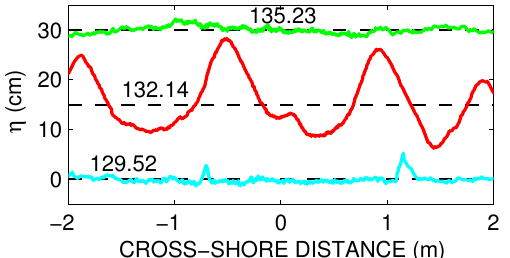
Figure 7. Selected profiles of bed elevation, η , with the bed slope removed. The numbers (in black) above each profile indicate the corresponding Yearday (see the roughness time series in Figure 6). Successive profiles are o ff set by 15 cm in the vertical. Cross-shore distance is positive o ff shore.